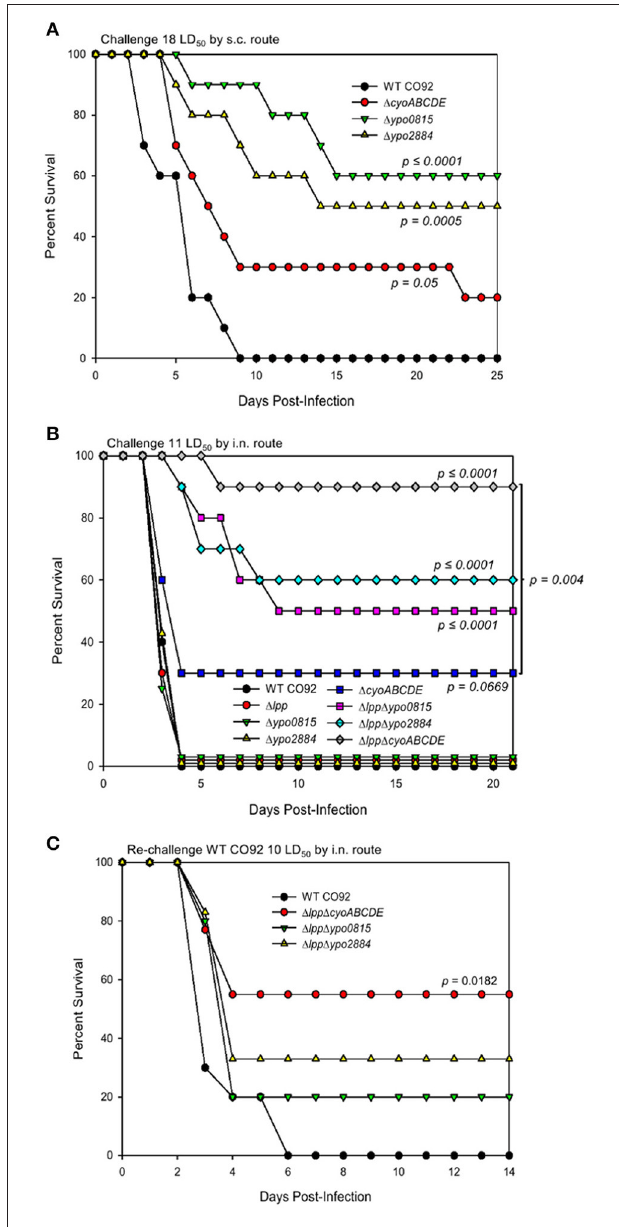
FIGURE 1 | Role of Y. pestis CO92 genes identified through the signature-tagged mutagenesis screen in virulence using bubonic and pneumonic plague mouse models. Survival analysis of female Swiss-Webster mice infected with WT CO92 or one of the indicated mutant strains ( n = 10) in a bubonic plague model at the dosage equivalent to 18 LD 50 of WT Y. pestis CO92 (A) or in a pneumonic model at the dosage equivalent to 11 LD 50 of WT Y. pestis CO92 (B) . Animals were monitored for up to 25 days p.i. (C) Survived mice ( n = 5–9) following the initial i.n. mutant infections (B) and a group of naïve control mice ( n = 5) were subsequently challenged with 10 LD 50 WT CO92 and observed for morbidity/mortality for 14 days p.i. (35 days total from initial infection). The data were analyzed for significance by using Kaplan–Meier survival estimates. The P -values were determined based on comparison